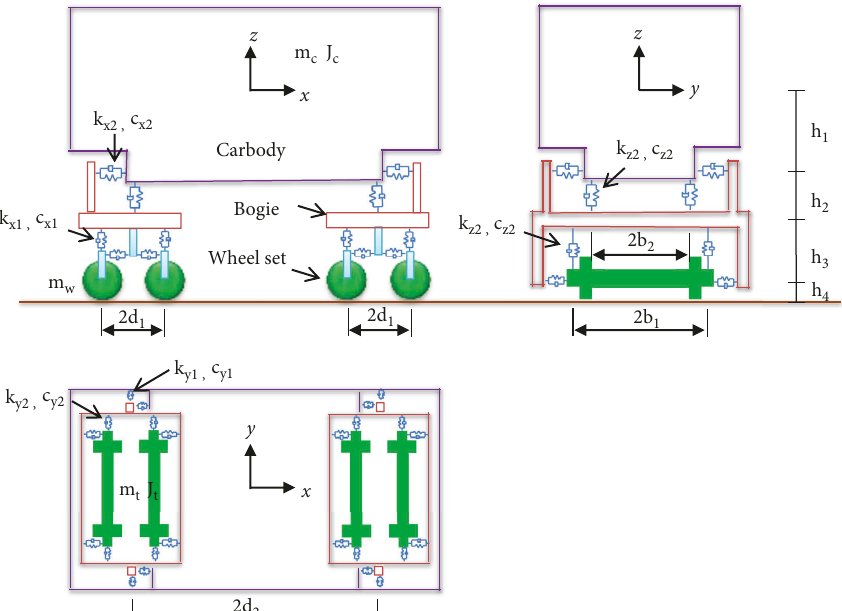
Figure 4: Vehicle model.